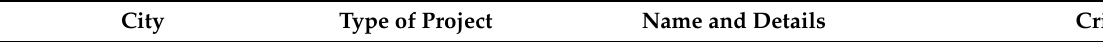
Table 2. List of the selected study cases. Source: Own